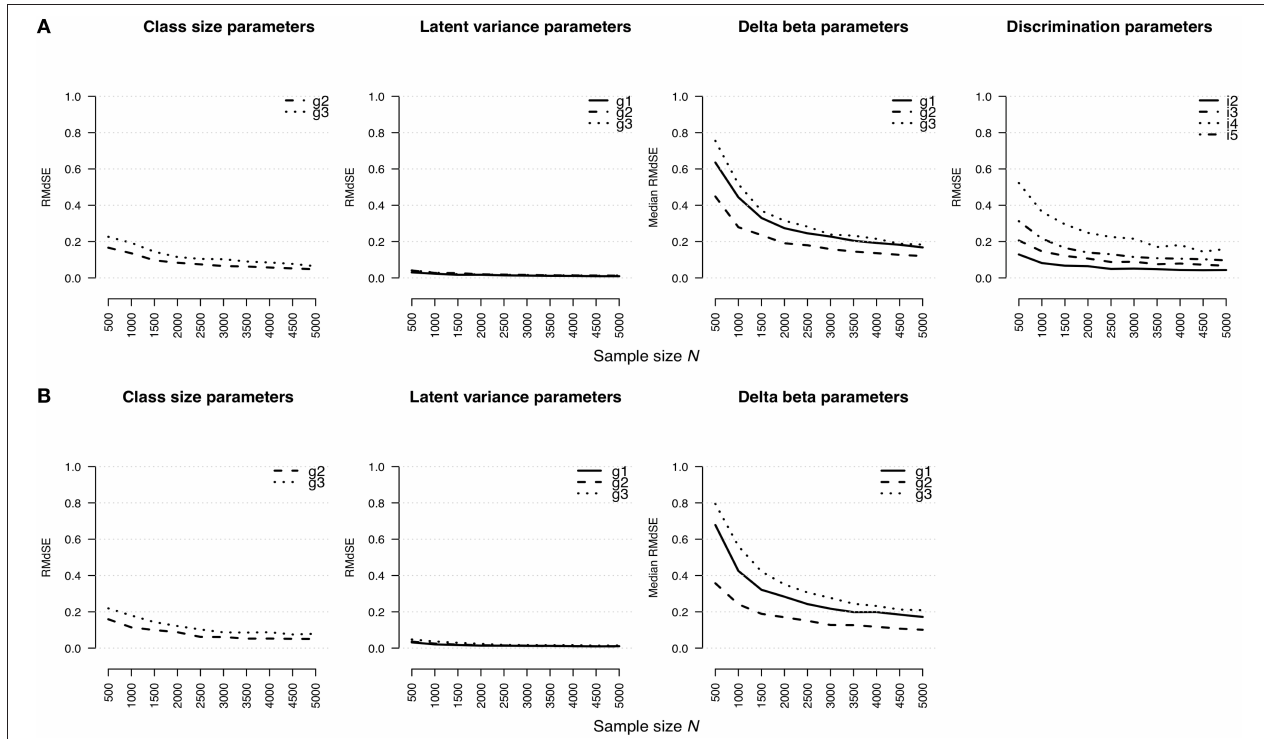
FIGURE 1 | Root median squared error for parameter estimates in (A) the rmGPCM-3 and (B) the mPCM-3 under the condition of a three-class mixture and a 5-item scale with 11